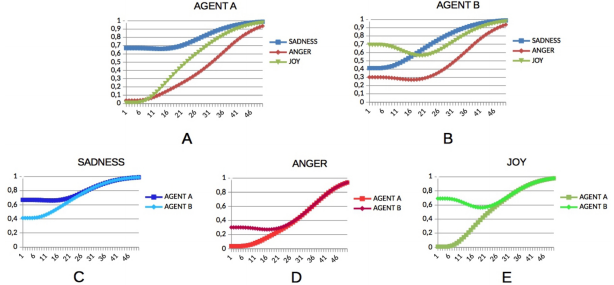
Fig. 5. Simulation results for amplification combined with absorption scenario set to upwards tendency, simulating three emotions SADNESS , ANGER and JOY : A) emotional dynamic of agent A , B) emotional dynamic of agent B , C) emotional dynamic of SADNESS on agents A and B , D) emotional dynamic of ANGER on agents A and B , and E) emotional dynamic of JOY on agents A and B . The horizontal axis denotes time elapsing in number of iterations and the vertical axis denotes emotional level. In this scenario, first emotions tend to meet each other in a sort of average, and then upwards spirals are